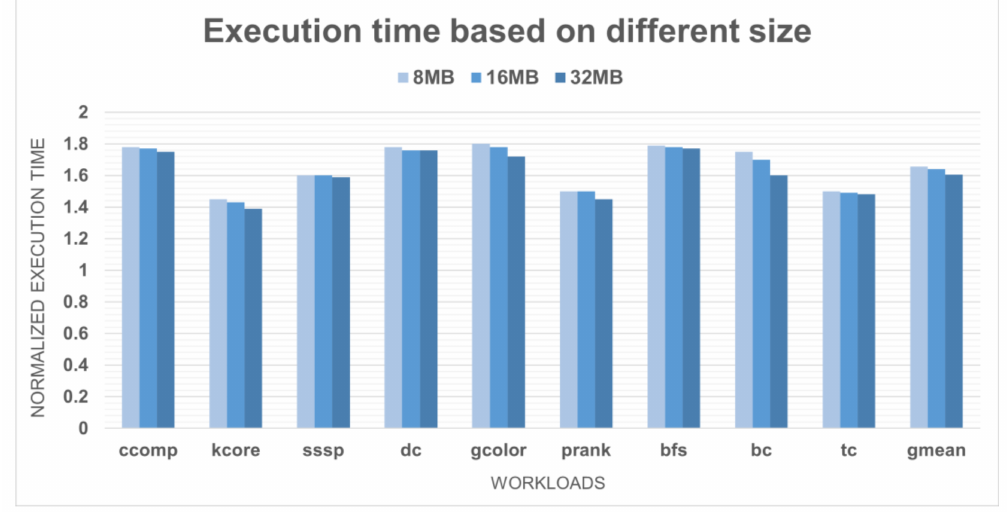
Figure 9. Execution time with respect to buffer